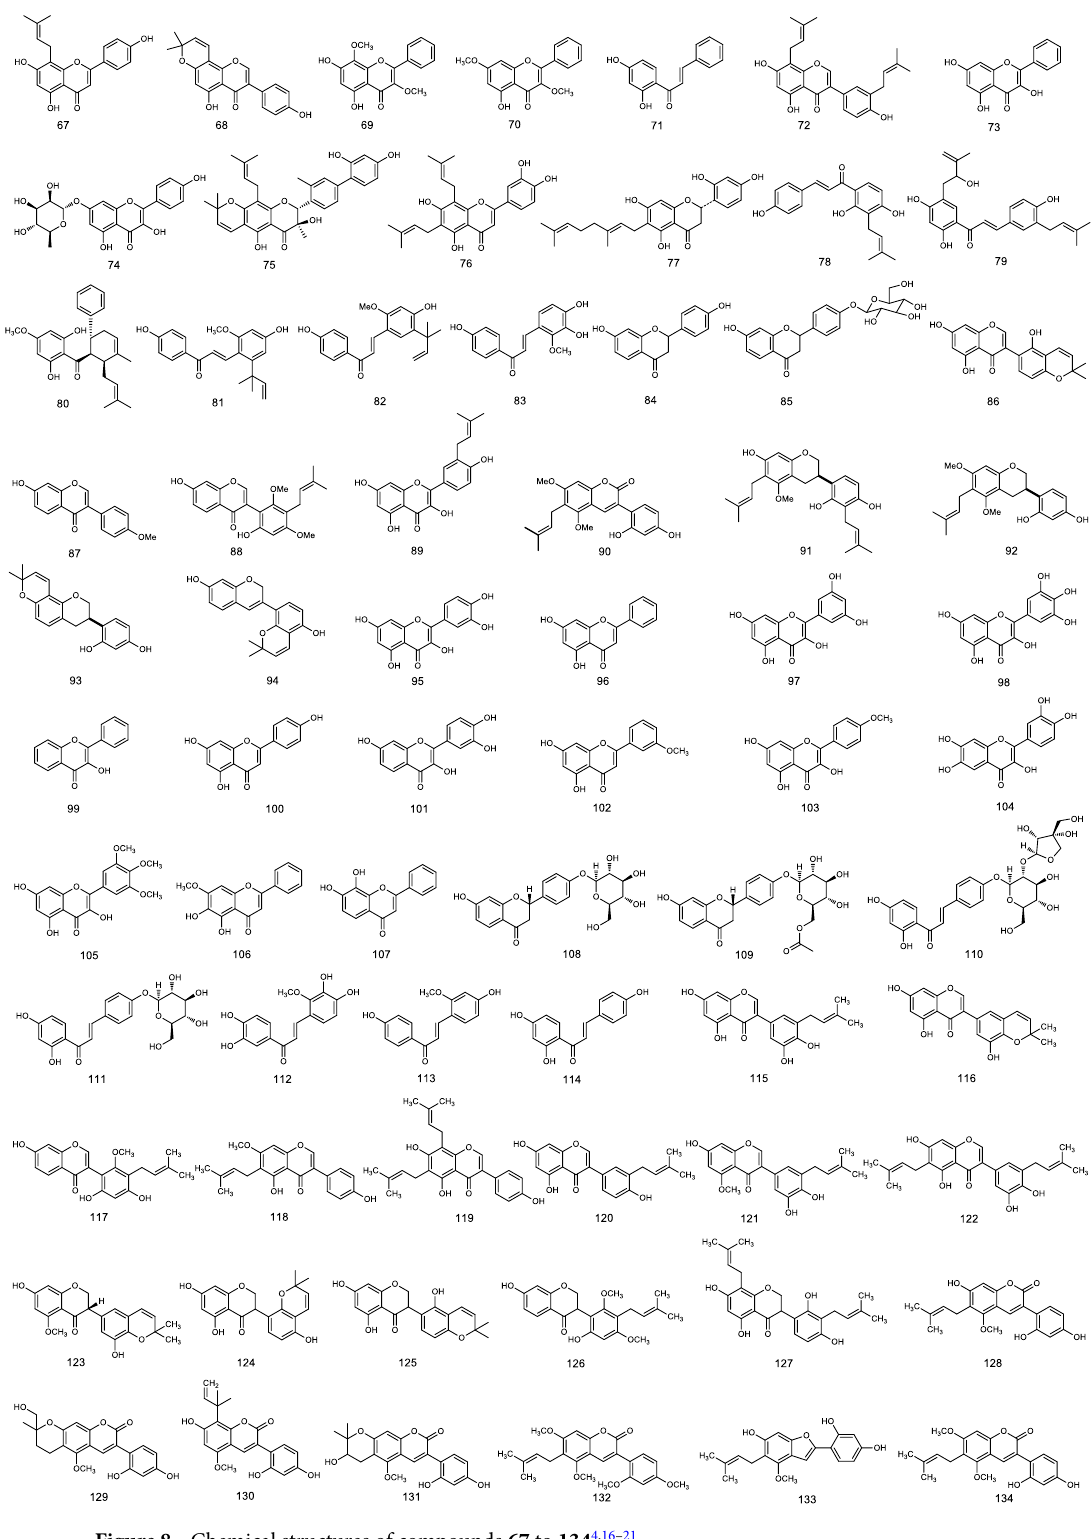
Figure 8. Chemical structures of compounds 67 to 134 4,16–21